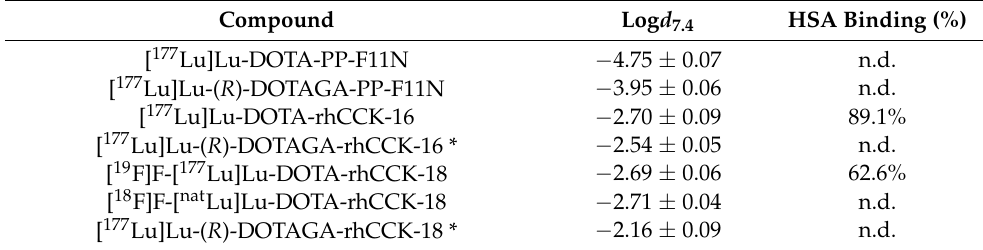
Table 1. Lipophilicity (log D 7.4 ) and HSA binding data of the 177 Lu-labeled peptides. Compound